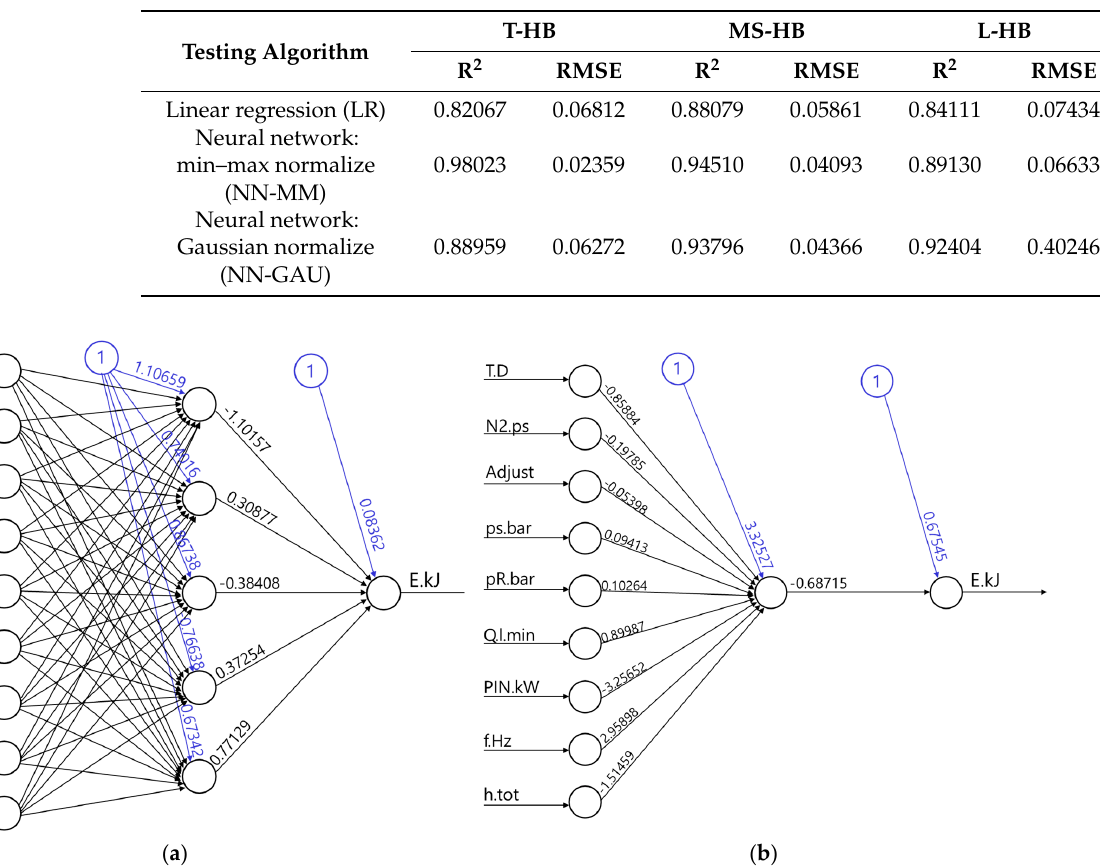
Table 4. Performance values of predicted test data.